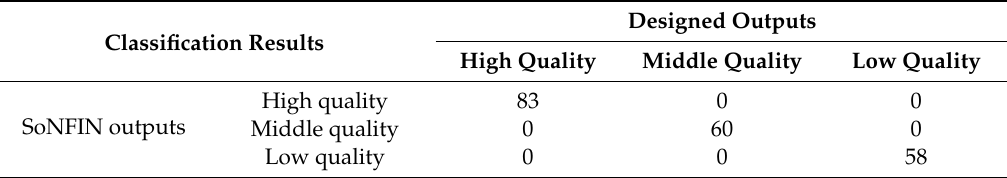
Figure 8. Comparison between the desired output and SoNFIN output in the training phase. Table 1. The results of SoNFIN classification in the training